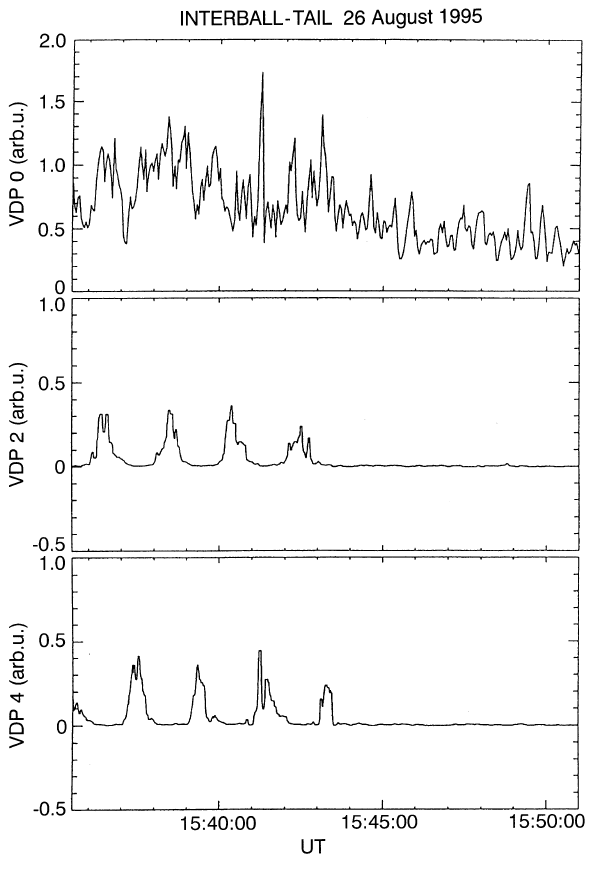
Fig. 4. Bow shock crossing measured by three